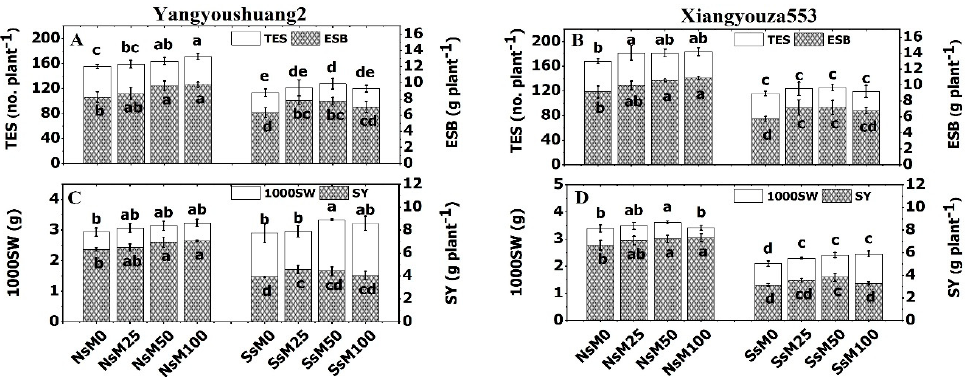
Xiangyouza553; ( C ) 1000SW and SY of Yangyoushuang2; ( D ) 1000SW and SY of Xiangyouza553. Bars